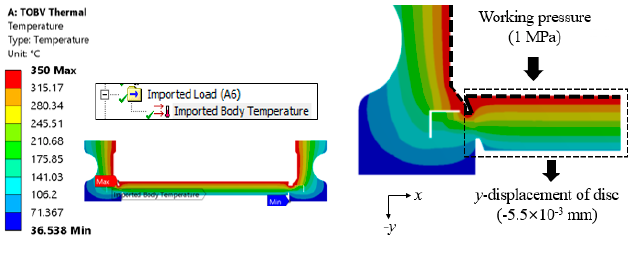
Figure 15. Analysis conditions of thermal-structural coupled simulation.